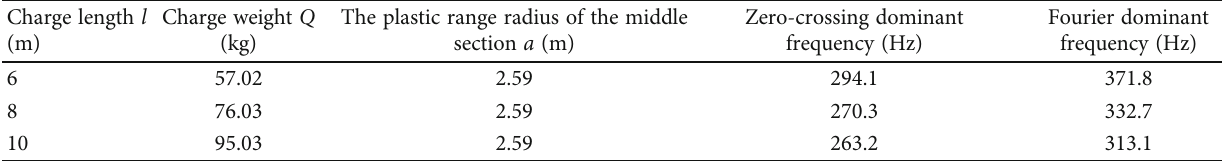
Table 6: Radius of plastic zone under di ff erent charge length.